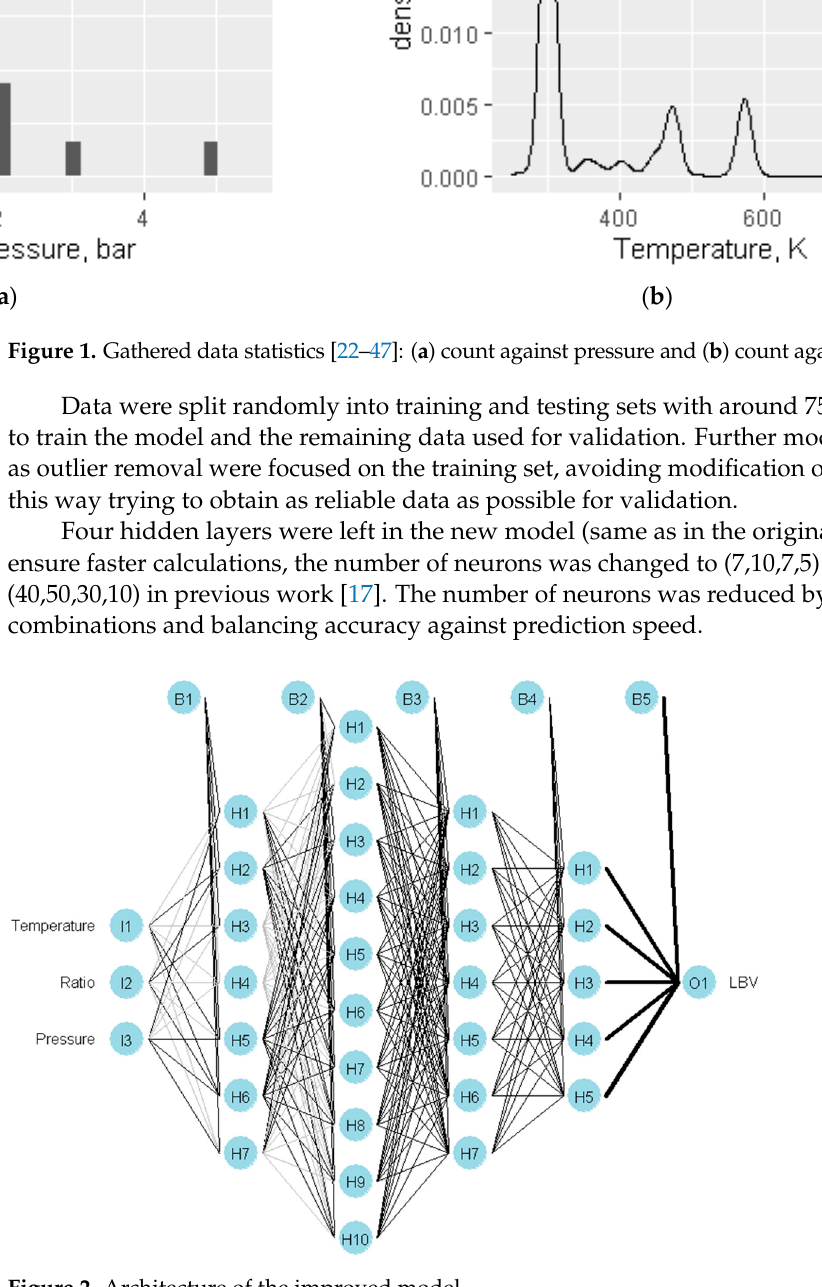
Figure 2. Architecture of the improved model.